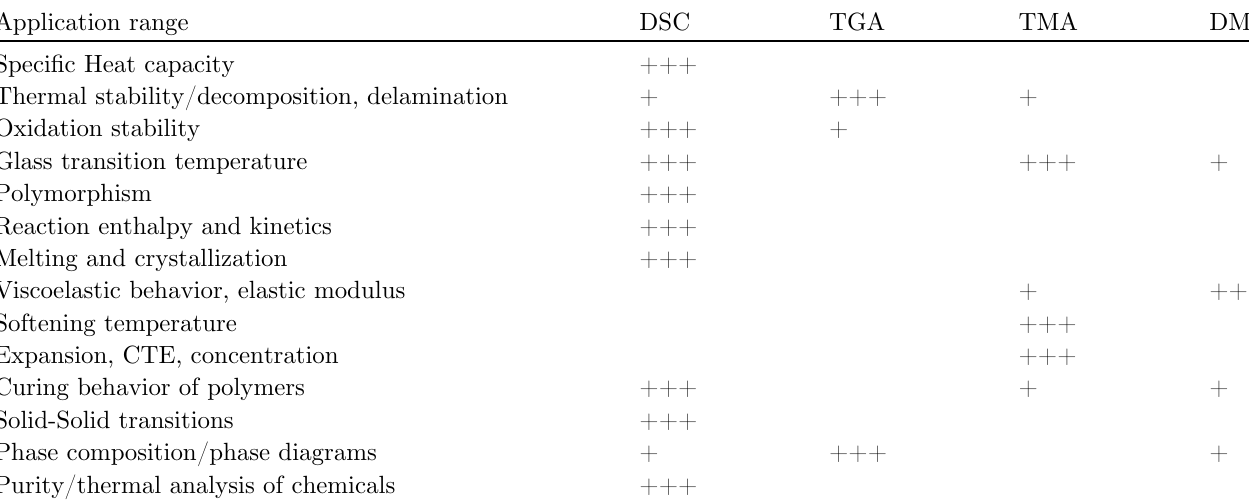
Table 1. Application overview of Thermal Analysis methods in coatings